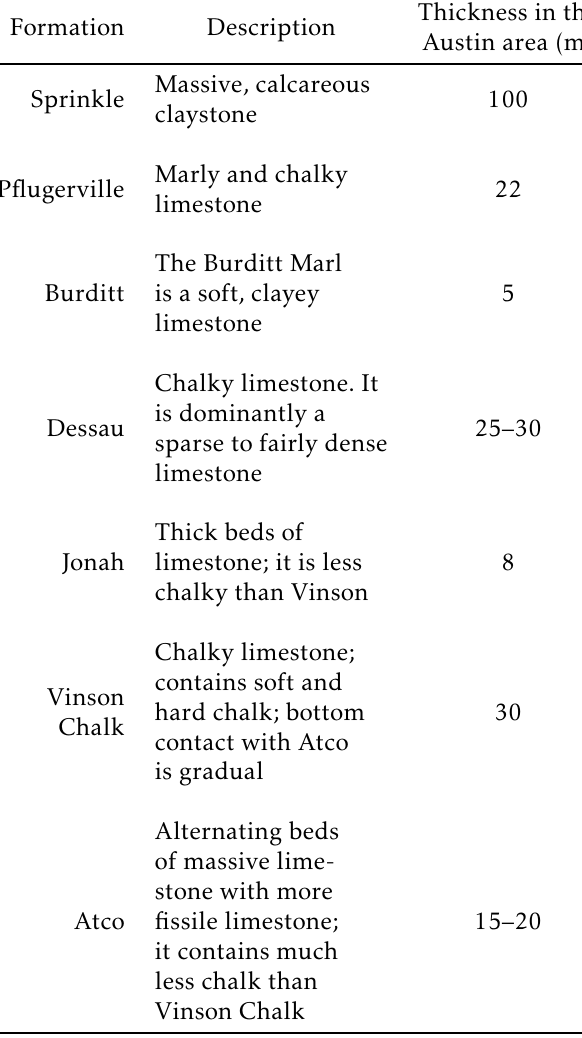
Table 1: Stratigraphic relationship between formations of the Austin Group (modified from Young and Wo- odru ff [1985]). Underlying and overlying the Austin Group are Eagle Ford and Taylor formations, respec- tively.